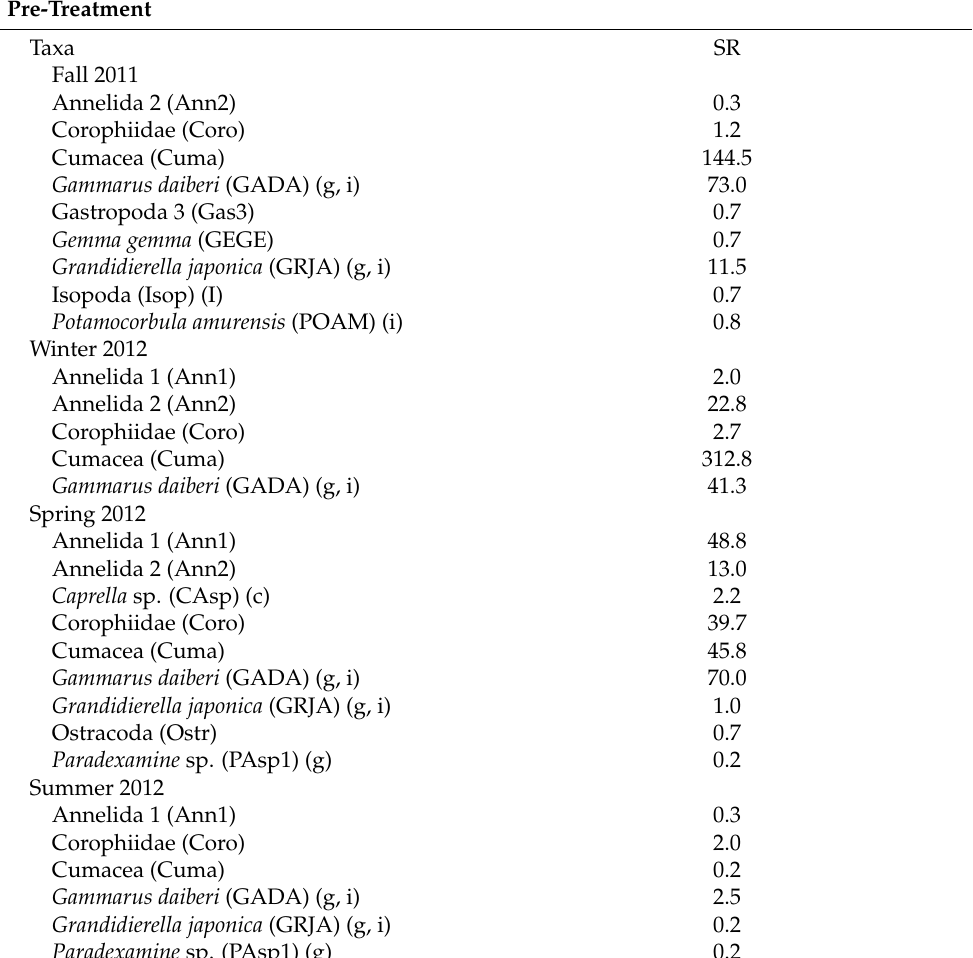
Table A1. Suction-sampled invertebrate community composition and mean abundance per sample in the pre-treatment sampling periods. Letters represent family and order (c = caprellid, g = gammarid, I = isopod), and native (n), introduced (i), or cryptogenic (c). See Figure 1 for site abbreviations.